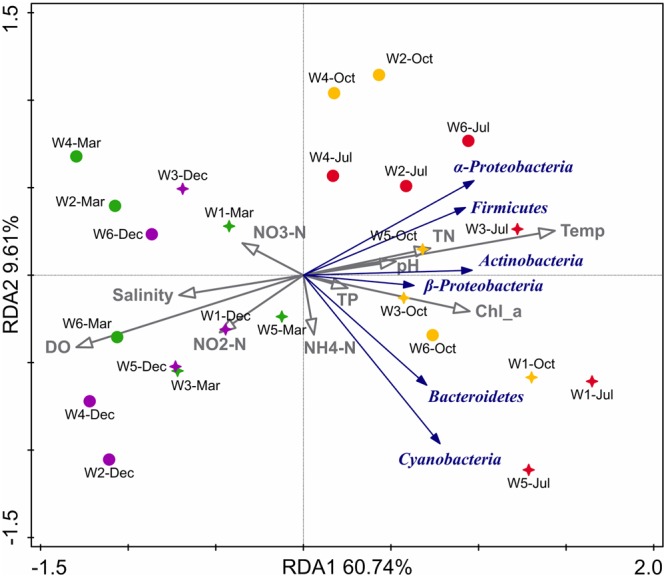
Biplot of redundancy analysis (RDA) showing relationship between the environmental variables and 16S rRNA gene abundance (qPCR quantification) of major phylogenetic groups in six stations near Qinhuangdao coastal area. The two RDA axes (RDA1 and RDA2) explained 70.35% of total variation in abundance data, and the significant (p < 0.01) explanatory variables were temperature (temp), dissolved oxygen (DO), and Chlorophyll a (Chl_a). Blue arrows represent different phylotypes, gray arrows represent environmental parameters, stars represent near-shore samples and circles represent off-shore samples. Different colors of the star or circle symbols represent different sampling time, with March samples in green, July samples in red, October samples in yellow and December samples in purple.